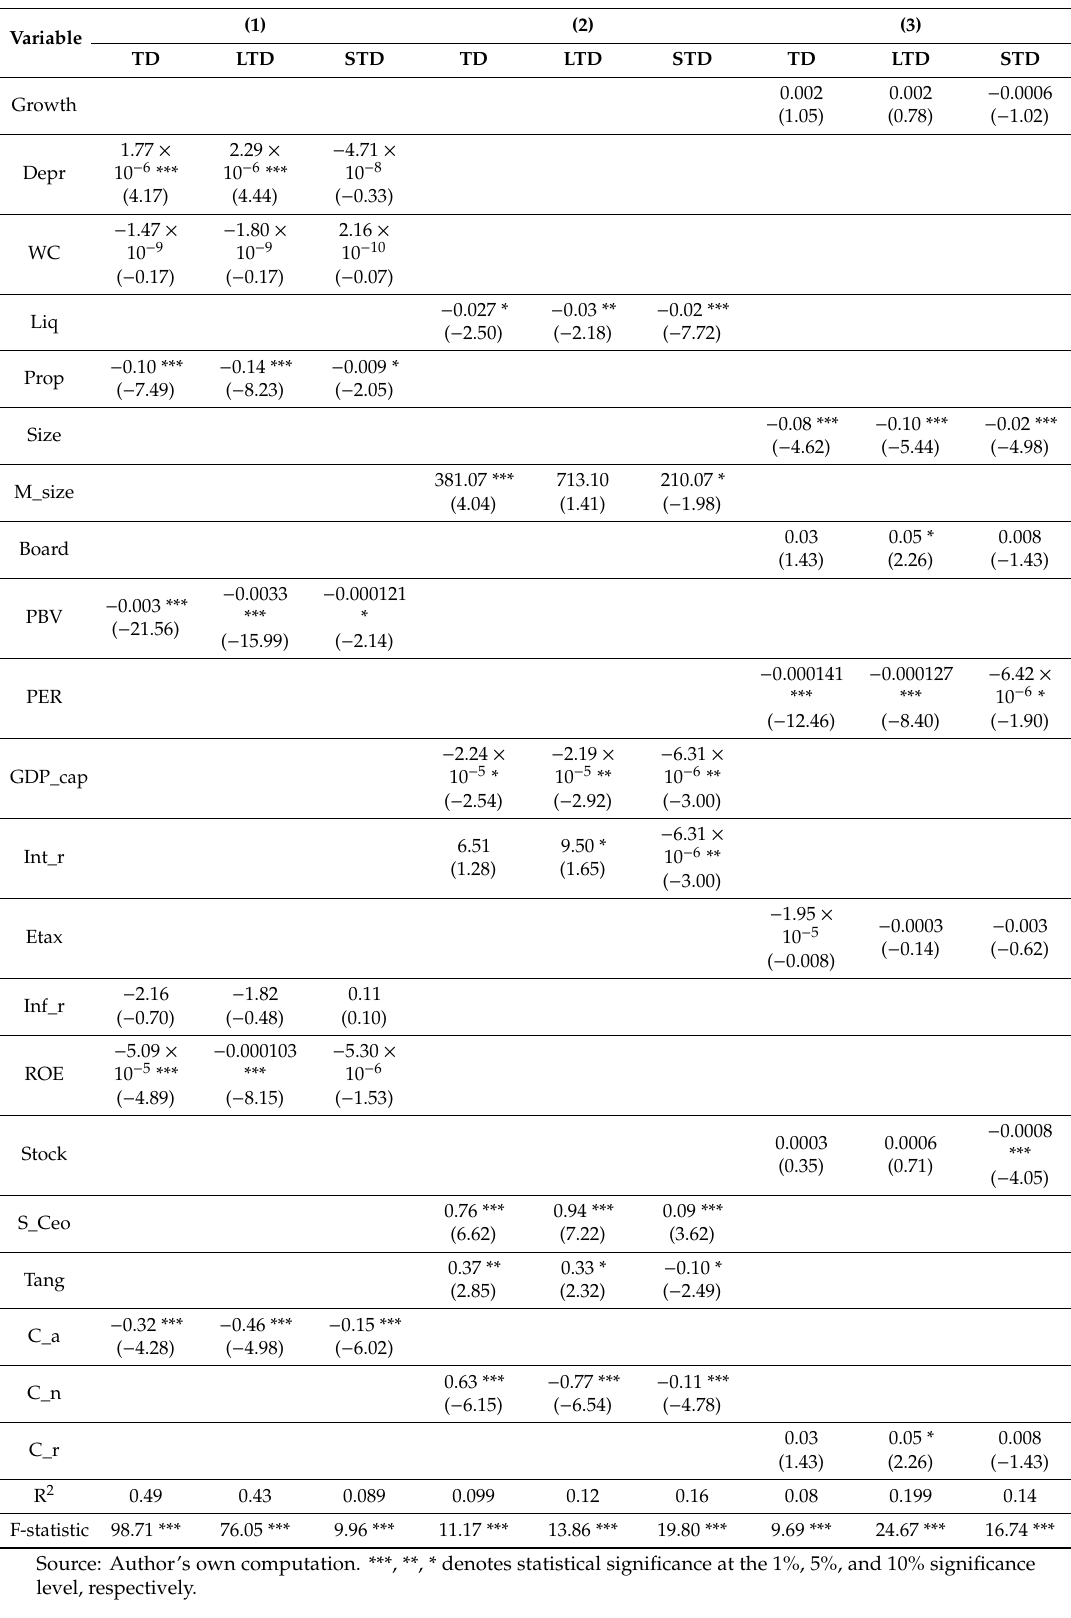
Table 5. Estimated coe ffi cients for all three